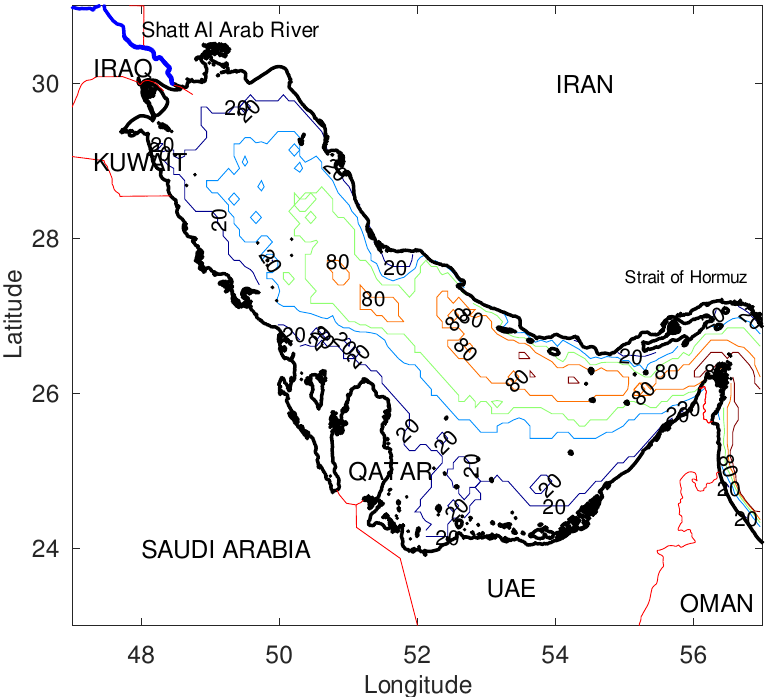
Figure 1. Map of the APG, which corresponds to the present model domain. Isobaths of 20, 40, 60, 80 and 100 m are